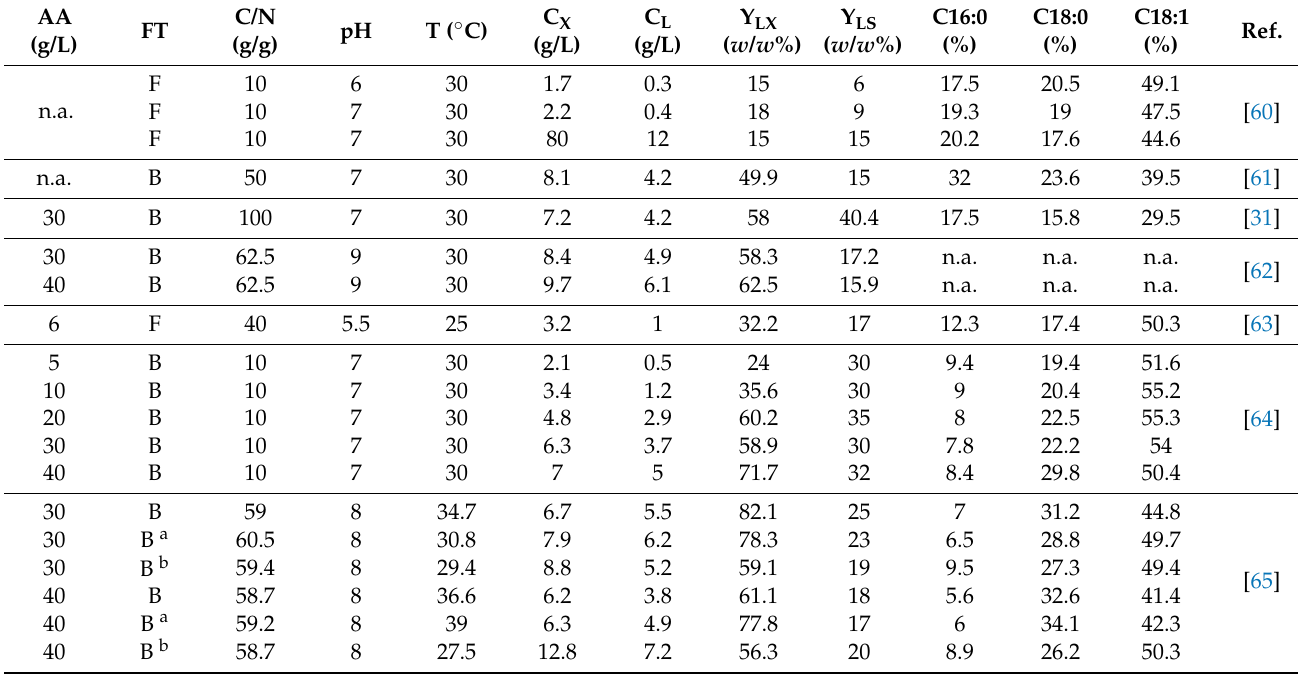
Table 1. Bioconversion of acetic acid to single-cell oil by the biocatalyst C. oleaginosus